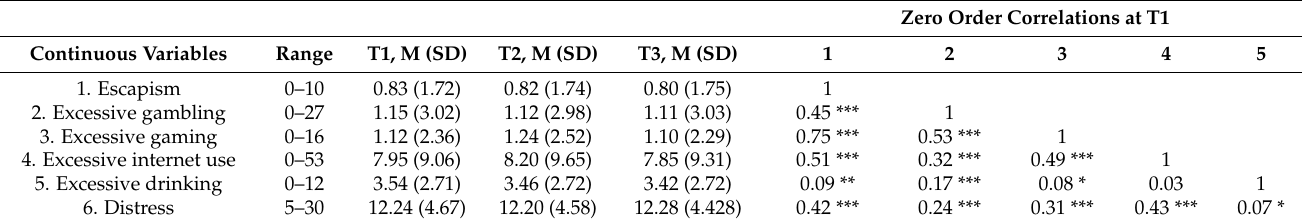
Table 1. Descriptive statistics of the main study